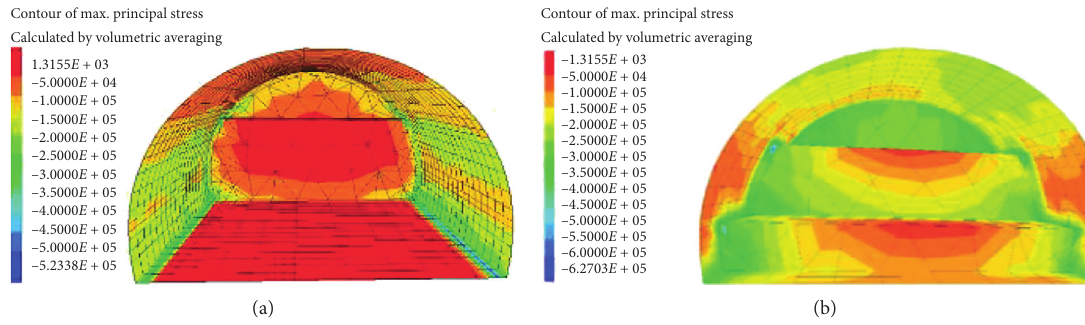
Figure 7: Stress distribution of the tunnel face: (a) condition 1; (b) condition